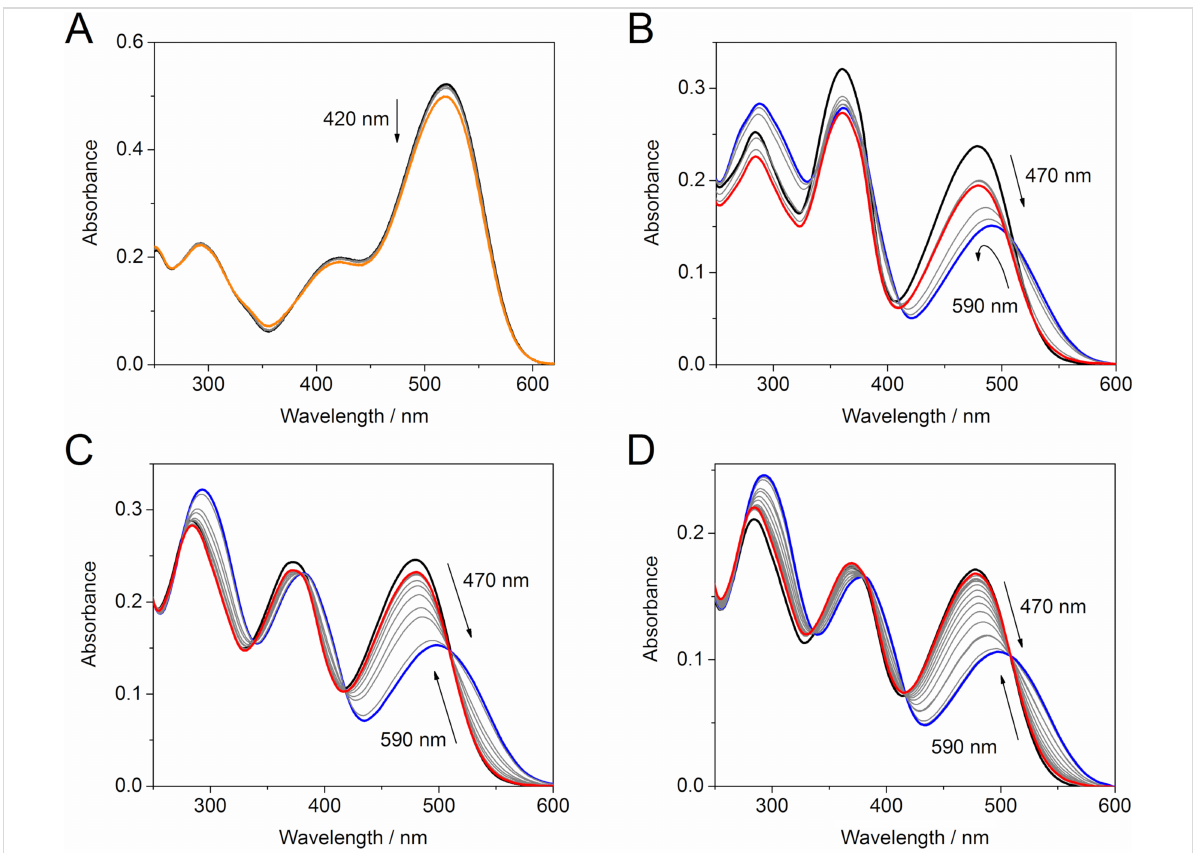
Figure 1: Photoswitching of hemi-indigo derivatives: (A) Z - 1a , c = 20 μ M in H 2 O with 10% (v/v) DMSO, λ ex = 420 nm; (B) Z - 1b , c = 20 μ M in H 2 O with 2% (v/v) EtOH, λ ex = 470 nm (forward reaction) and 590 nm (backward reaction); (C) Z - 1c , c = 20 μ M in H 2 O with 2% (v/v) EtOH, λ ex = 470 nm (forward reaction) and 590 nm (backward reaction); (D) Z - 2 , c = 15 μ M in H 2 O, λ ex = 470 nm (forward reaction) and 590 nm (backward reaction), 20 °C. Spectra of the initial Z -isomers: black; PSS 420 : orange; PSS 470 : blue; PSS 590 :